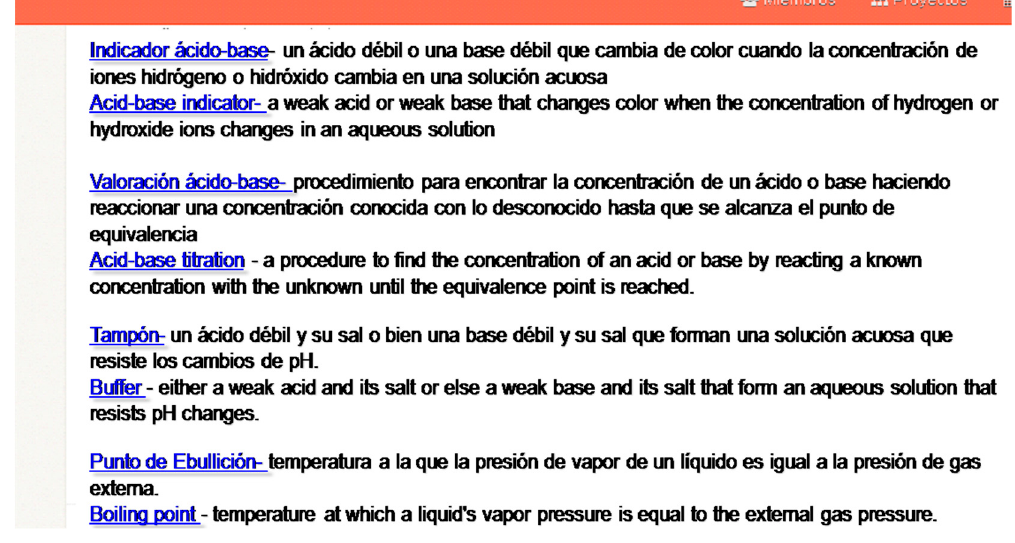
Figure 3. Fragment of the joint dictionary prepared by the wiki